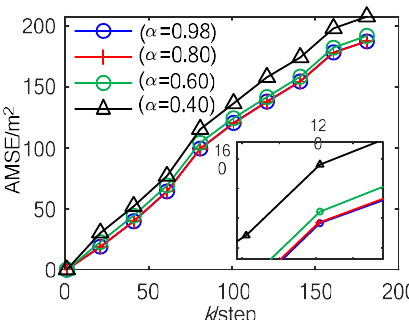
Figure 2. AMSE of the ET-KF algorithm with different α